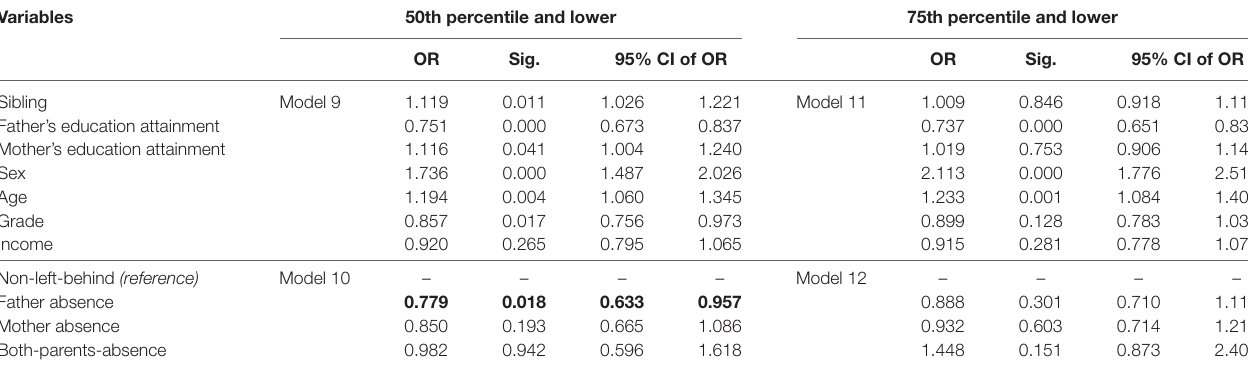
TaBle 4 | Logistic regression models for predicting lower scores in English tests. Variables 50th percentile and lower 75th percentile and lower Or sig. 95% ci of Or Or